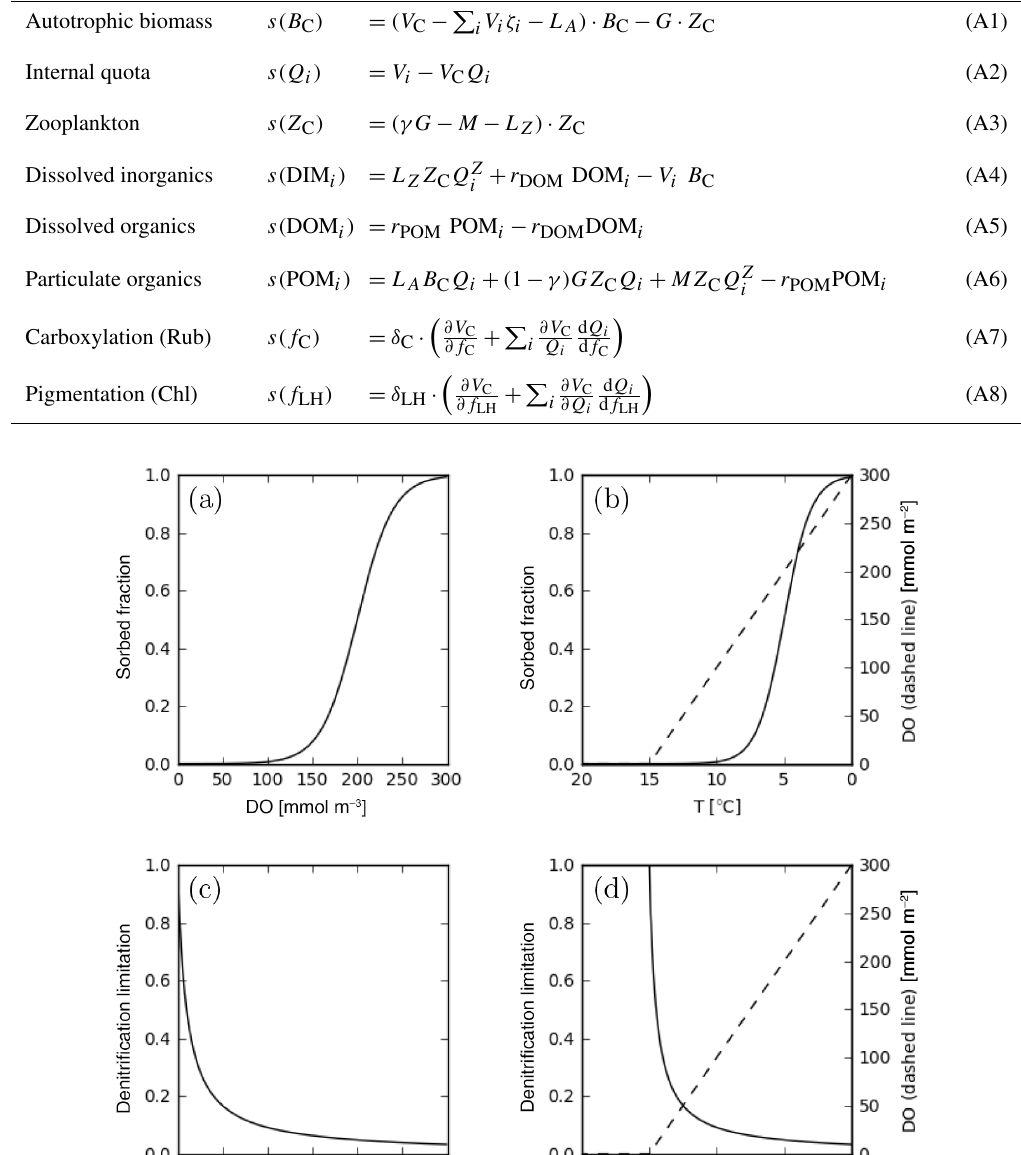
Table A1. Source–sink terms of the dynamic variables of the pelagic module. The index i represents the elements C, N and P. By definition, = 1 and Q i = B i /B Q C = Q Z C . The dynamics of dissolved inorganic carbon (DIC) are not resolved; thus Eq. A4 is not integrated for i C Descriptions of processes or functional relationships (capital letters) and of parameters (lowercase letters) are provided in Tables A2 and A3, respectively.